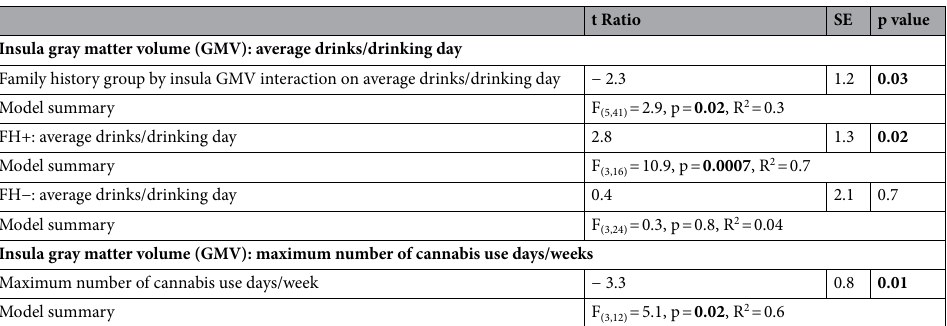
Table 3. Insula gray matter volume in relation to alcohol/cannabis use patterns. Relations between insula gray matter volume (GMV) with alcohol and cannabis use measures. Analyses with alcohol measures as the dependent variable were performed across all participants (bipolar disorder family history negative (FH−): N = 25; bipolar disorder family history positive (FH+): N = 17) who completed the Timeline Follow Back and reported lifetime alcohol use, using GMV extracted from clusters showing a significant negative relationship with Childhood Trauma Questionnaire (CTQ) total score. Analysis with the cannabis measure as the dependent variable was performed only in past month cannabis user (FH−: N = 6; FH+: N = 7). Results are reported for the overall models, the family history group by insula GMV interaction, and the alcohol/cannabis use factors within each model. SE = standard